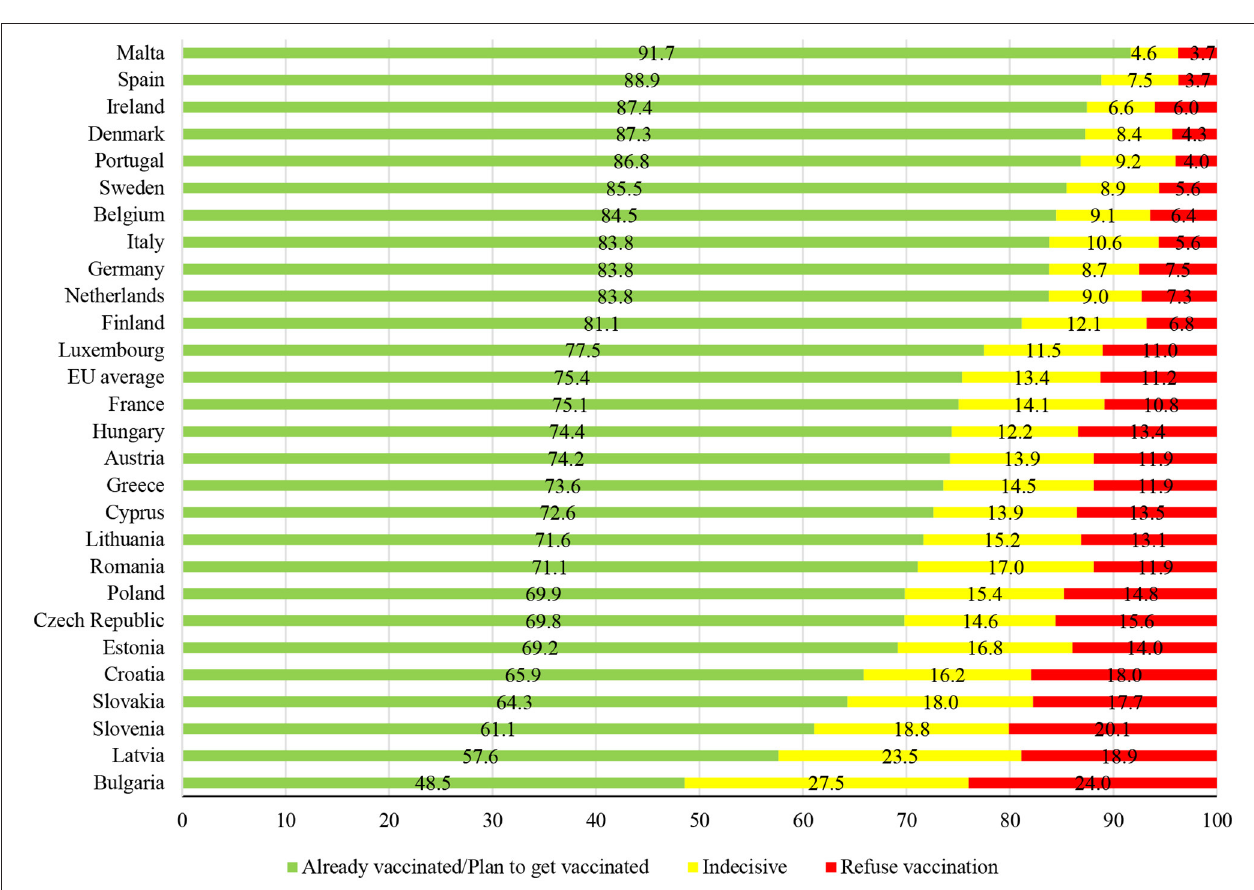
FIGURE 2 | Attitudes toward vaccination against COVID-19 across the EU, % of population. Source: Author’s own calculations based on data from Flash Eurobarometer